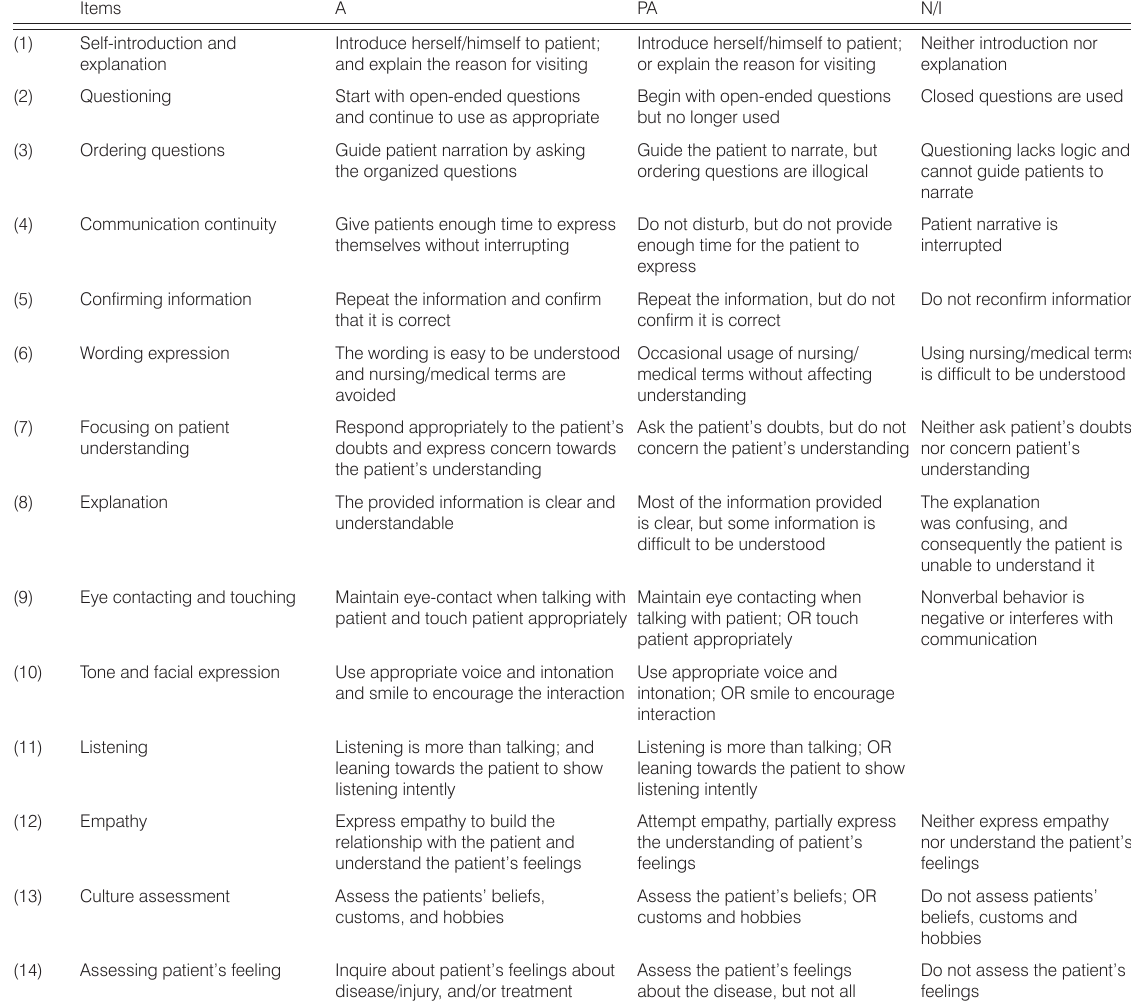
Table 2. Communication evaluation